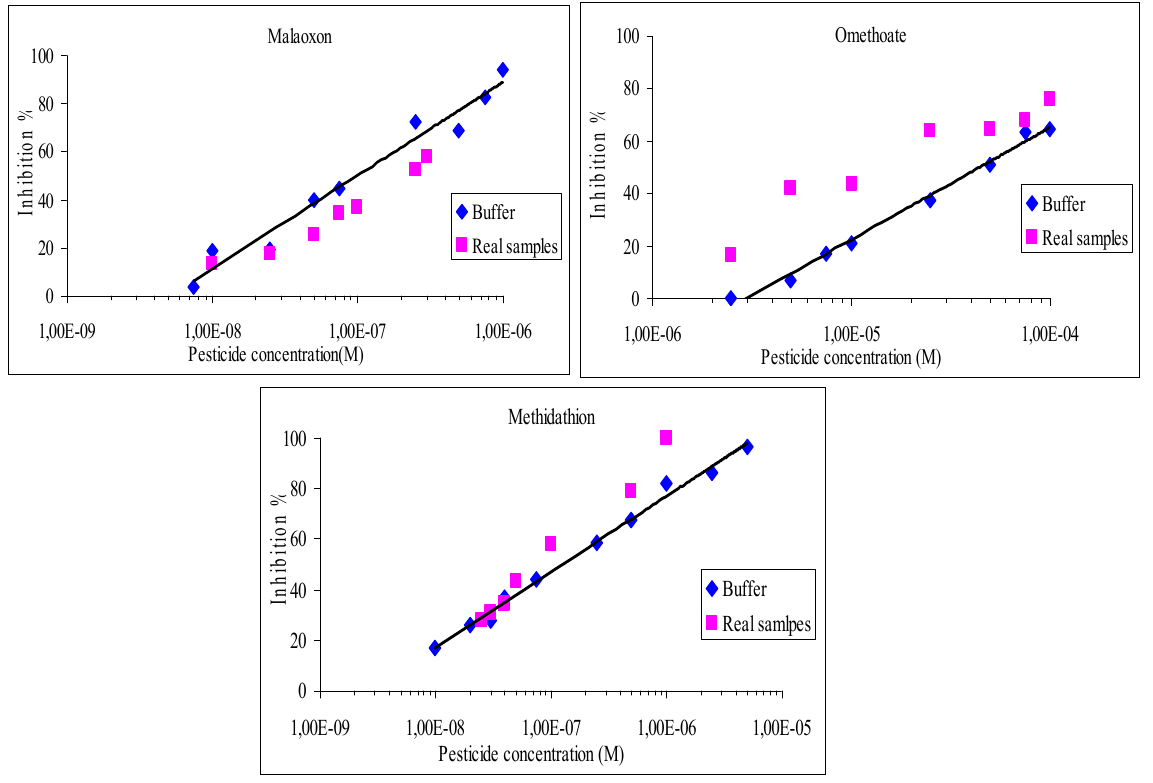
Figure 5. Comparison of inhibition effects of omethoate, methidathion and malaoxon in buffer or olive oil real samples, detection by amperometric